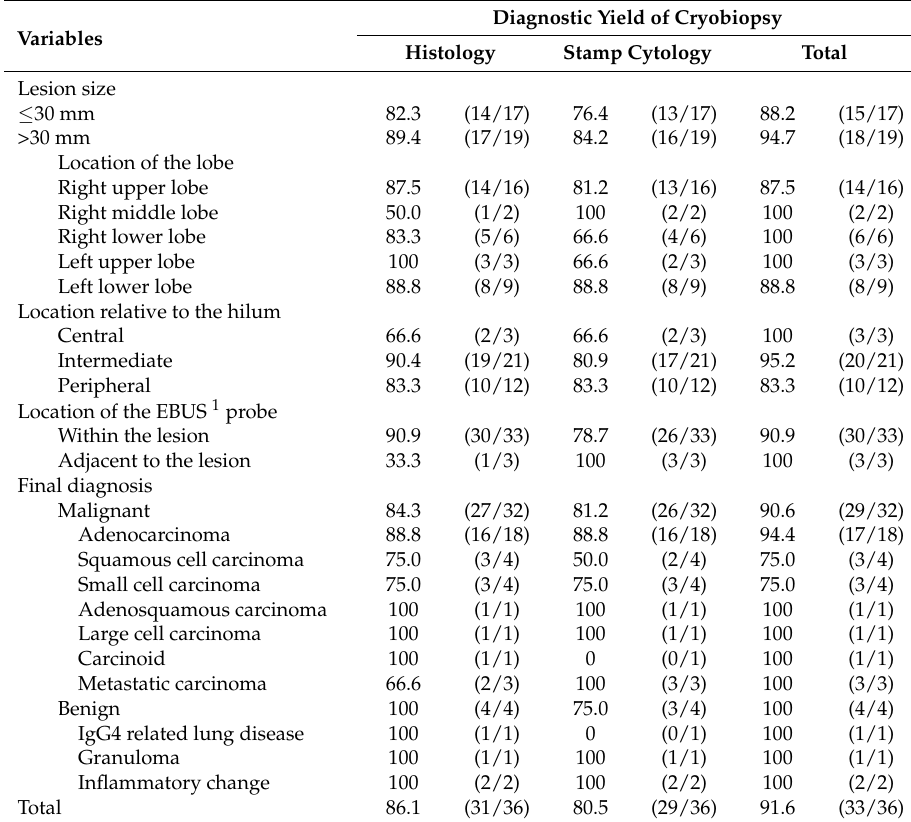
Table 1. Diagnostic yield of cryobiopsy according to the size, location, and diagnosis of peripheral pulmonary